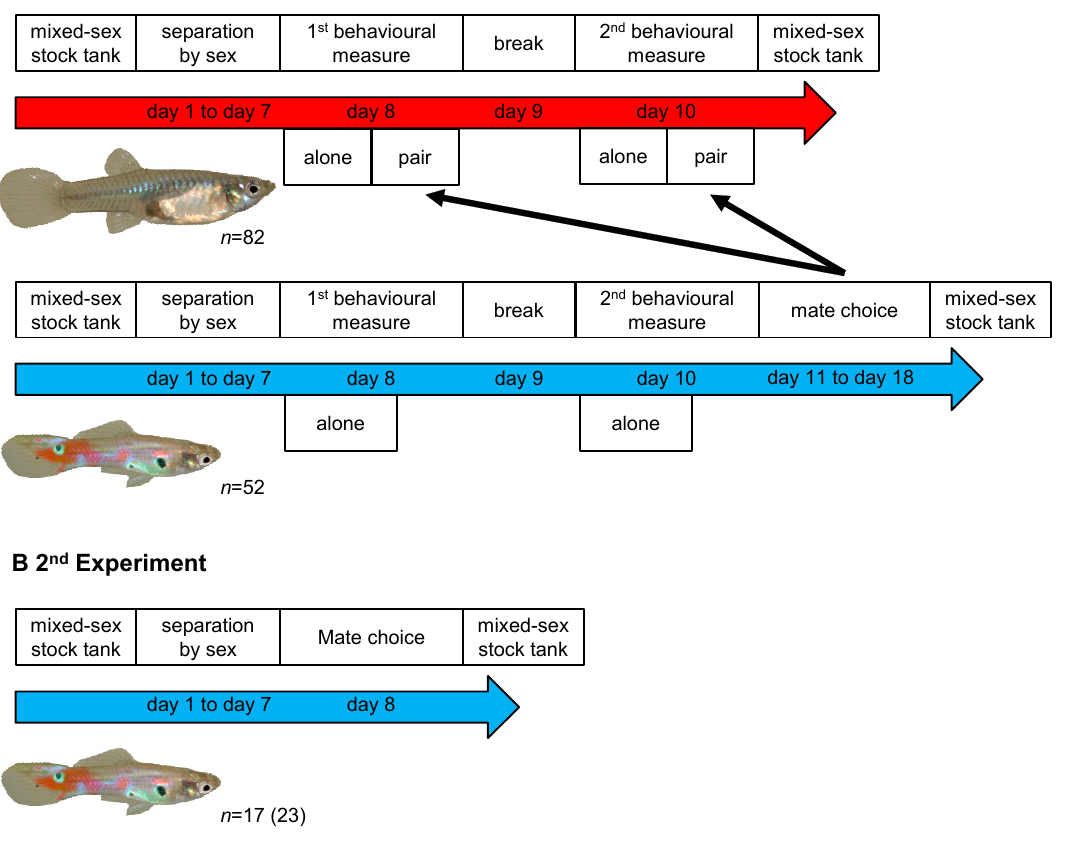
Figure 1. Schematic overview of the experimental timeline for experiments 1 ( A ) and 2 ( B ). Female activity was measured as described for males but each 5 min activity test was